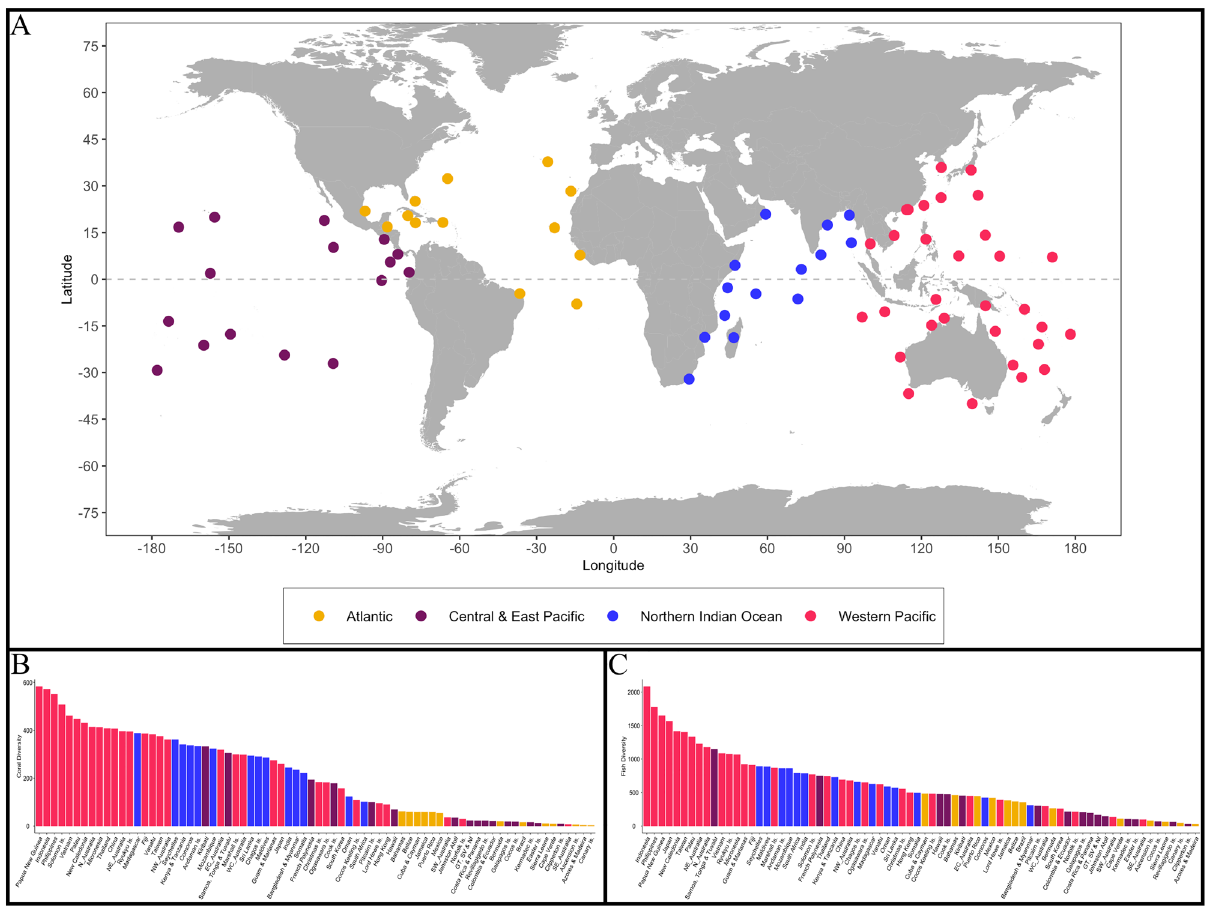
Figure 1. ( A ) 74 global ecoregions categorized into four oceanic regions, represented by distinct colours ( B ) Coral species richness present in each ecoregion ( C ) Fish species richness present in each ecoregion. Generated using the ‘ggplot2’ package in RStudio version 3.6.1 41 . Figure 1A was created using ggplot2’s map_data 300 species of coral (Fig. 4; Adjusted R 2 = 0.97, F (1, 72) = 2633, p < 0.001). In combination, the richness of corals and associated hues were positively correlated with fish richness (Adjusted R 2 = 0.74, F (3, 70) = 69.15, p < 0.001), with the combination of both accounting for more of fish community’s variability than when either was evalu- ated separately (Fig. 4). Furthermore, model selection supported coral richness and associated hue as the best predictor of fish richness (Table S2). The influence of coral richness and hue on fish intra-family richness varied considerably among the four oceanic regions (Figs. S7, S8, S10). The Central and East Pacific (Adjusted R 2 = 0.75, F (3, 12) = 16.3, p < 0.001), and Western Pacific (Adjusted R 2 = 0.60, F (3, 27) = 16.3, p < 0.001.) exemplified the global trend (Fig S7). Whereas, coral richness and hue diversity’s correlation with reef fish richness was consider- ably higher within the Atlantic relative to the global average (Adjusted R 2 = 0.88, F (3, 9) = 30.8, p < 0.001; Fig S7). The extent of this association was reduced within the Northern Indian Ocean due to higher fish richness within South Africa and Oman (Adjusted R 2 = 0.09, F (4, 9) = 1.31, p > 0.1; Fig S7). Coral hue homogenization. Reefs exhibit distinct hue heterogeneity. The colour distance matrix arranged the bleached and healthy reefs according to observed hue diversity, forming three separate groups, which pri- marily corresponded to the region’s coral richness (Figs. 1, 5). The Australian and Indonesian reefs formed a distinct group relative to the other areas considered, indicating that their colouration is similar. Taiwan, and Turks and Caicos exhibited a comparable orientation; however, their colouration was more analogous to Ameri- can Samoa than to Australia or Indonesia. Coral bleaching homogenized colouration, producing the most sub- stantial measure of colour dissimilarity (Fig. 5). Among the pairwise distance comparisons of the bleached and healthy reefs, elevated levels of dissimilarity corresponded to increased colour diversity within the unbleached reefs. An analysis of the published literature indicated that coral bleaching-induced colour homogenization decreases fish species richness, abundance, and the survivorship of recruits, with declines in abundance varying among fish families (Fig. 5, Table S3).